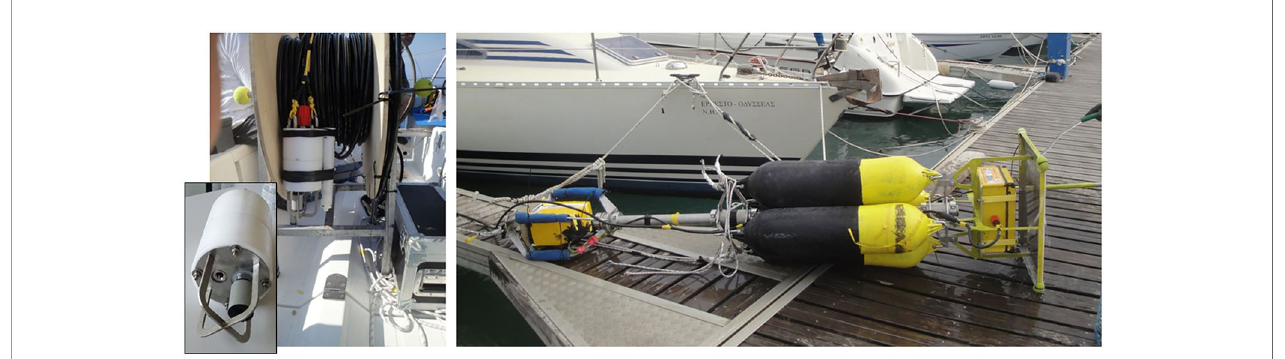
FIGURE 1 | The SWAN acoustic station (from left to right): Hydrophone canister with Benthowave hydrophone and STS depth/temperature sensor, power/data cable, battery, fl oats, CPU box, solar panel